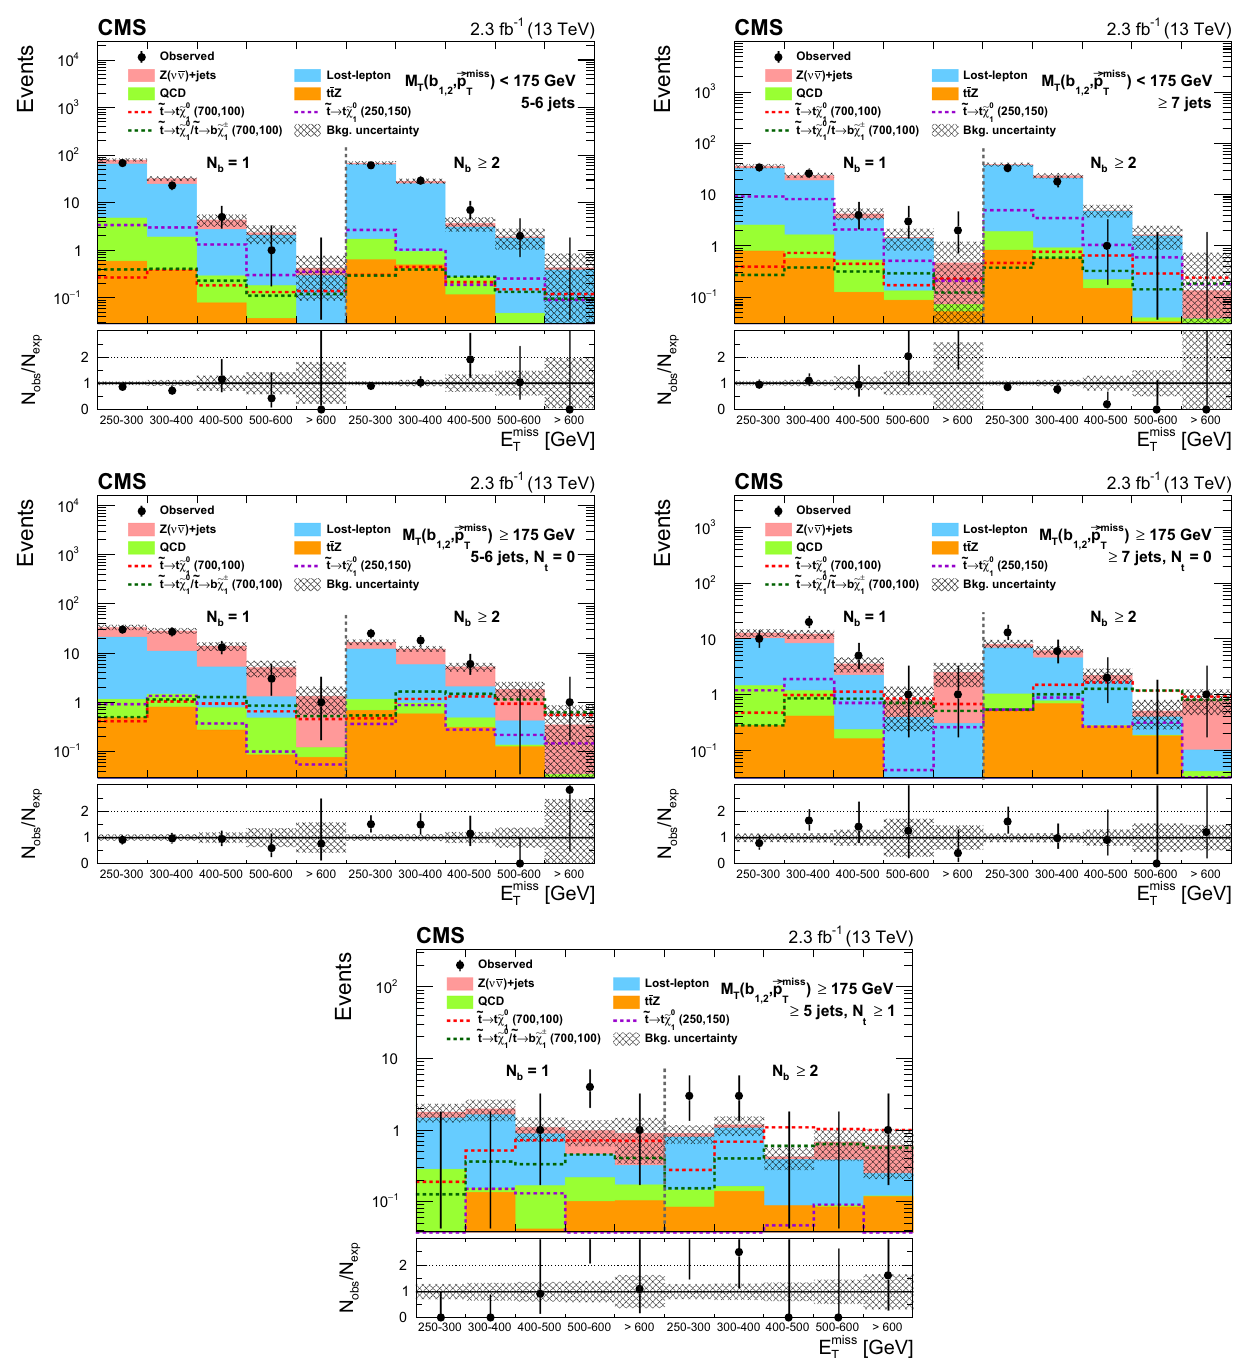
Fig. 3 ObservedandestimatedSMbackgroundandsignalyieldsinthe 400–500, 500–600, > 600GeV for N b = 1, and the second five bins ) < SRs of the top squark search in the all-jet final state: M T ( b 1 , 2 , (cid:5) p miss correspond to the same E miss T ) < 175GeV, N ≥ 7 predictions shown do not include the effects of the maximum likelihood 175GeV,5 ≤ N j ≤ 6( upperleft ), M T ( b 1 , 2 , (cid:5) p miss j T fit to the data. The ratio of the data to the SM prediction extracted from ) ≥ 175GeV, N = 0 , 5 ≤ N ≤ 6 ( mid- ( upper right ), M T ( b 1 , 2 , (cid:5) p miss t j T CRs is shown in the lower panel of each plot. The shaded black band ) ≥ 175GeV, N = 0 , N ≥ 7 ( middle right ), dle left ), M T ( b 1 , 2 , (cid:5) p miss t j T represents the statistical and systematic uncertainty in the background ) ≥ 175GeV, N ≥ 1 , N ≥ 5 ( bottom row ). The first M T ( b 1 , 2 , (cid:5) p miss t j T five bins in each plot correspond to E miss ranges of 250–300, 300–400, T